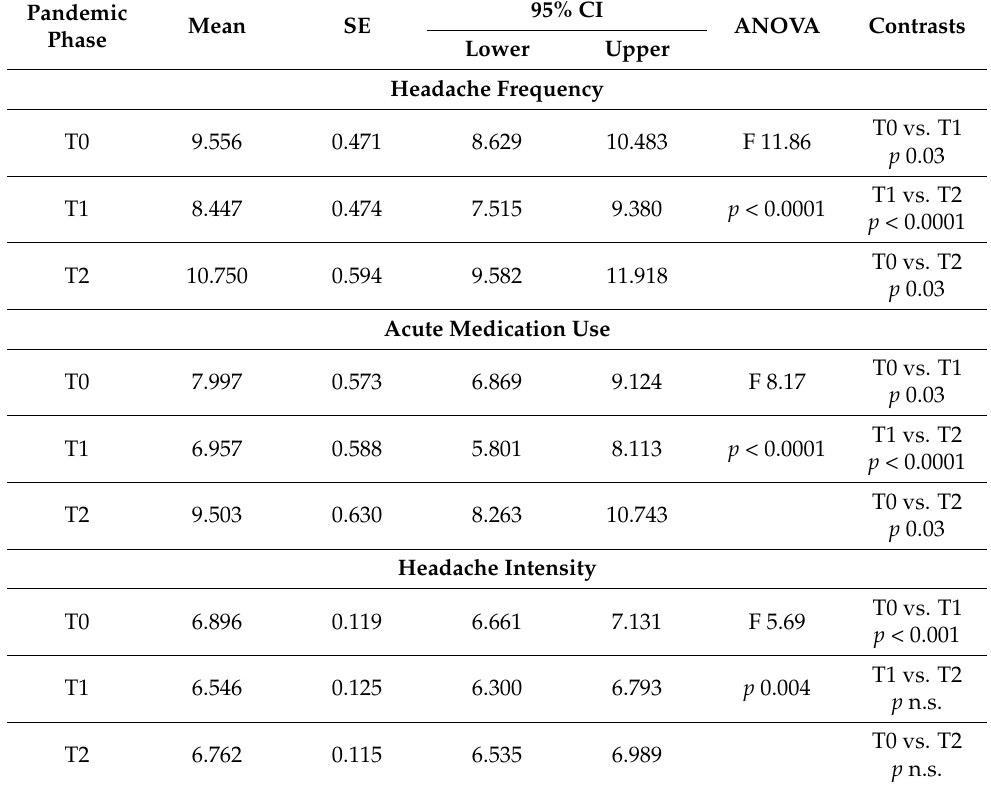
Table 3. Mean and standard errors (SE) of headache features in the three months before first pandemic phase (T0), during first-phase lockdown (T1), during second wave (T2). Headache frequency and number of symptomatic drugs are normalized in a monthly index. Headache intensity is rated on a 0–10 numeric scale. Results of repeated measures ANOVA and repeated contrasts are reported. Degree of freedom 2, degree of error